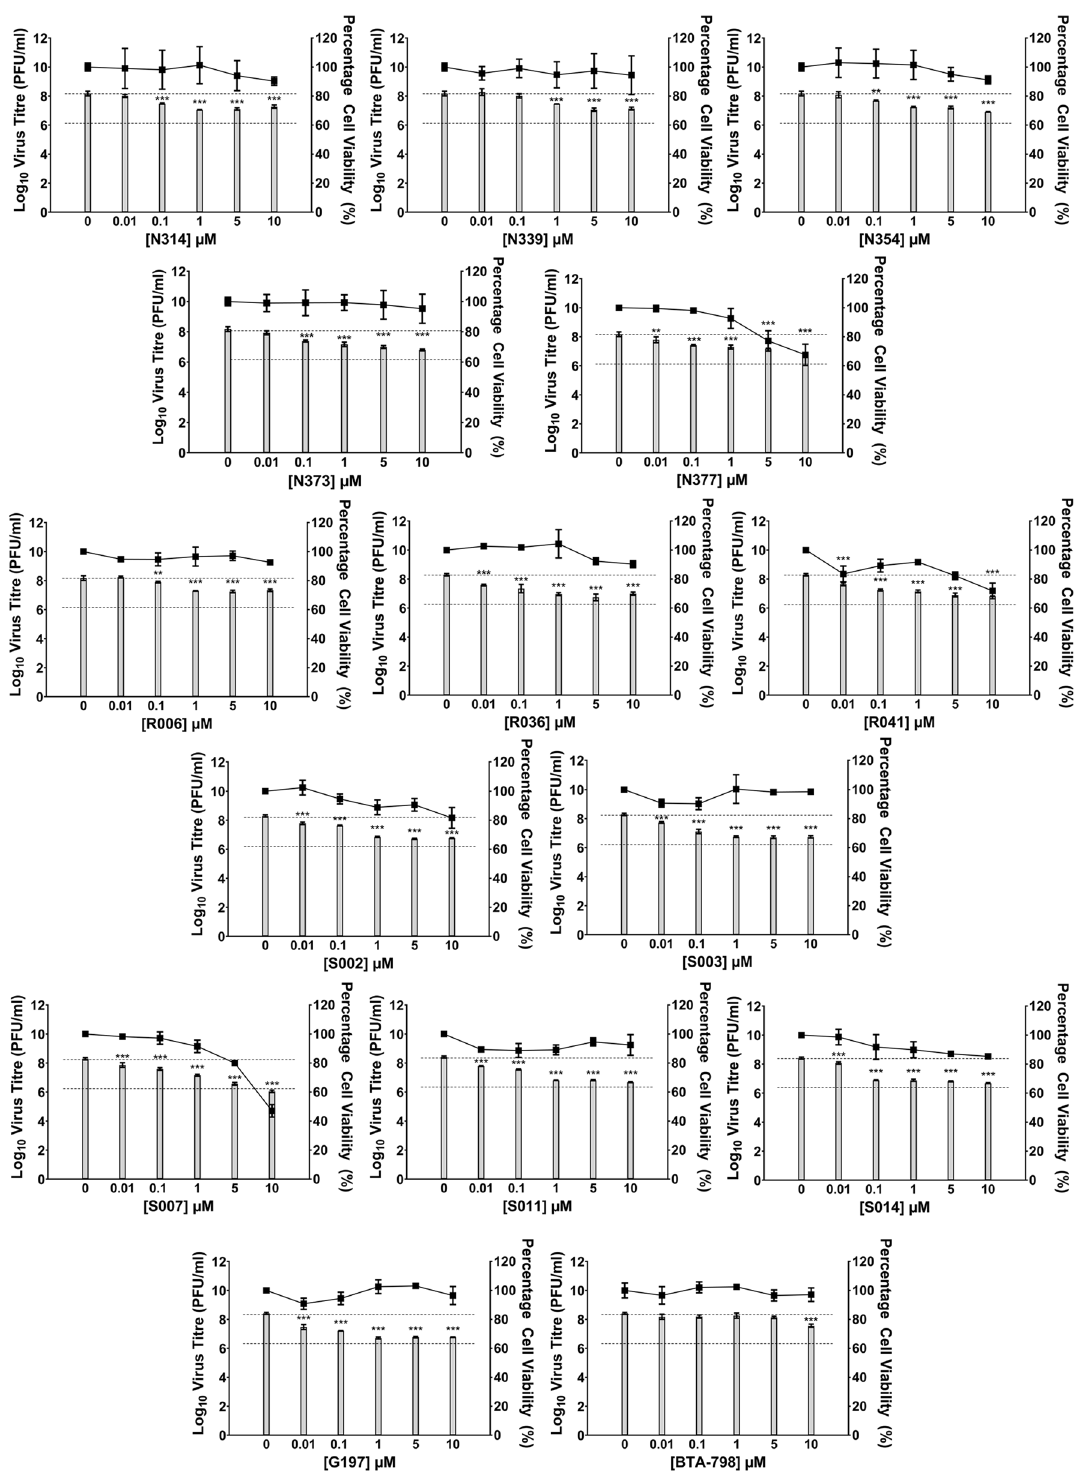
Figure 2. Effect of novel PI4KIIIβ and capsid inhibitors on the replication of EV-A71 in vitro. RD cells infected with EV-A71 was treated with each of the compounds at 5 different concentrations and 0 µM refers to control infected cells treated with 0.1% DMSO. Virus titres achieved at 12 h.p.i. was determined by viral plaque assays and represented as bars on each of the charts. Cell viability of drug-treated non-infected cells was assessed by alamarBLUE Cell Viability Reagent and expressed as a percentage compared to control DMSO-treated cells. Novel PI4KIIIβ inhibitors were: N314, N339, N354, N373, N377, R006, R036, R041, S002, S003, S007, S011 and S014. N373 was selected for further studies based on superior cell viability profile and inhibition of EV-A71 replication. G197 was found to be more effective in inhibiting EV-A71 replication than control capsid inhibitor BTA-798. Bars represent Log 10 virus titres (PFU/ml) and points represent cell viability across the different compound concentrations. Dashed lines indicate negative control virus titre (top line) and a 2 Log 10 unit reduction in virus titre (lower line). Statistical analysis for differences in virus titre due to drug treatment was performed with one-way ANOVA with Dunnett’s post-test: *( p < 0.05), **( p < 0.01), ***( p <